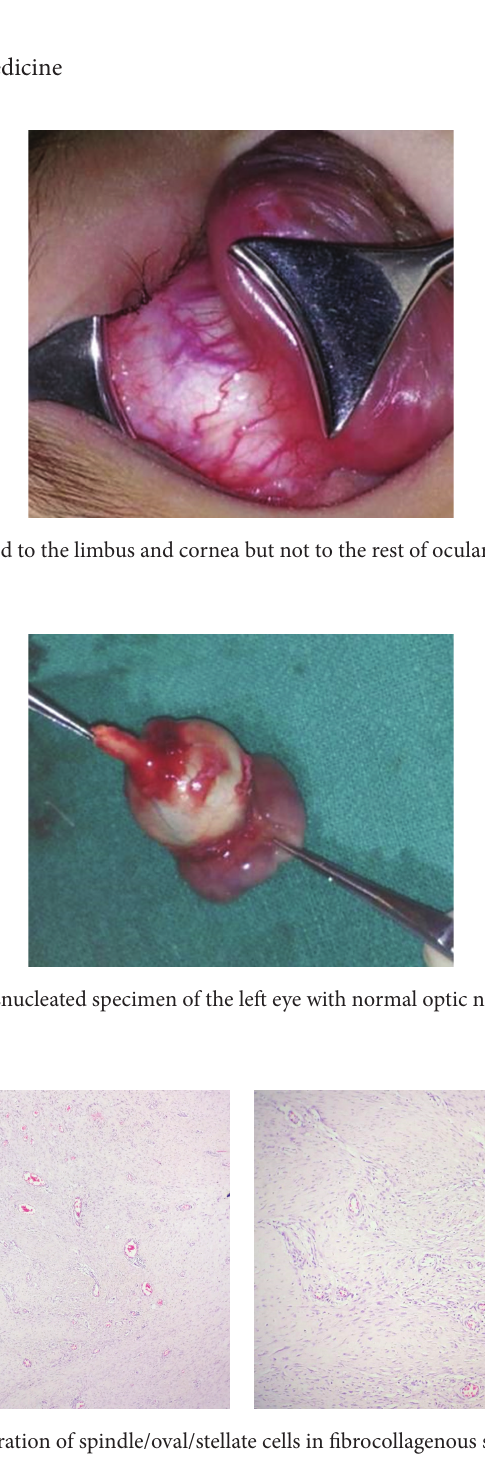
reported in association with vasculitis, inferior vena caval thrombosis and infections with mycobacterium, Epstein- Barr virus, actinomycetes, and mycoplasma